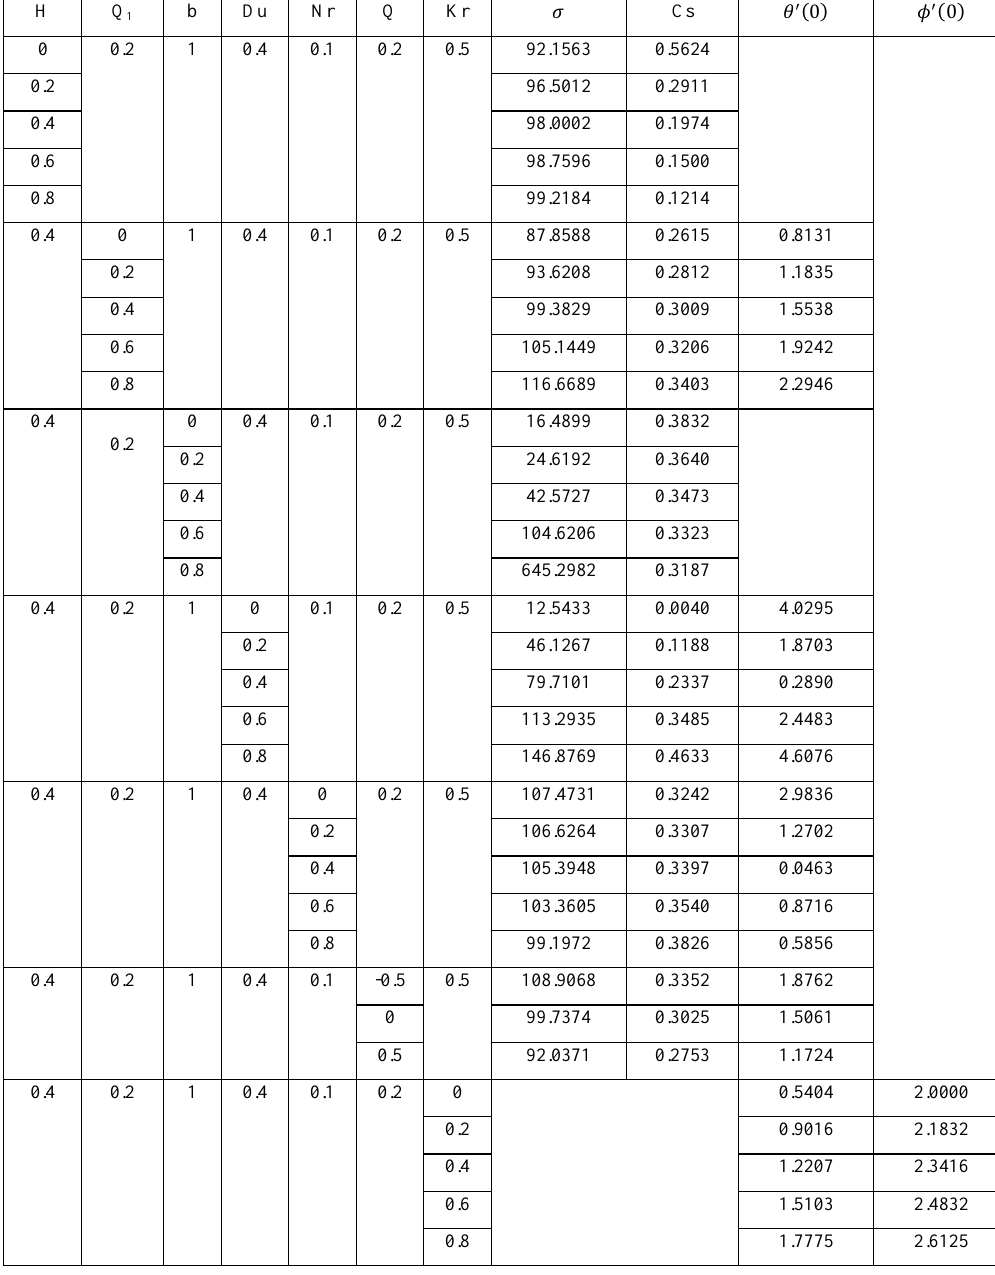
Table 1. Shear stress, couple shear stress, rate of heat transfer and rate of mass transfer for Pr=5, M=2, Sc=2, e=0.001, eta (η)=0.2, n=0.1, Kp=0.3, Gr=5, n 1 =0.2, Gm=0.3 at